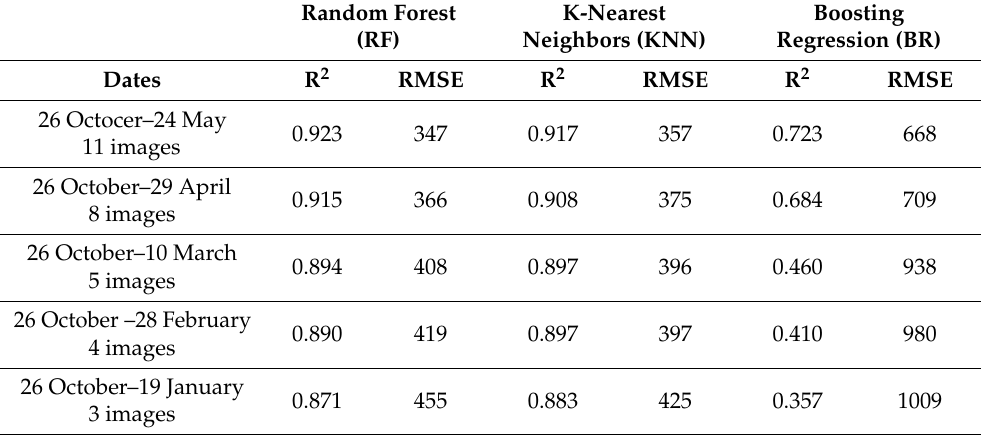
Table 2. Performance comparison of the three machine learning approaches for yield estimation, with the use of different number of images per growing period. R 2 , coefficient of determination and RMSE, root mean square error (kg ha − 1 ) between measured and modeled yield. Data concern 66 fields during three growing periods, corresponding to 9463 pixels. Random Forest K-Nearest Boosting (RF) Neighbors (KNN) Regression